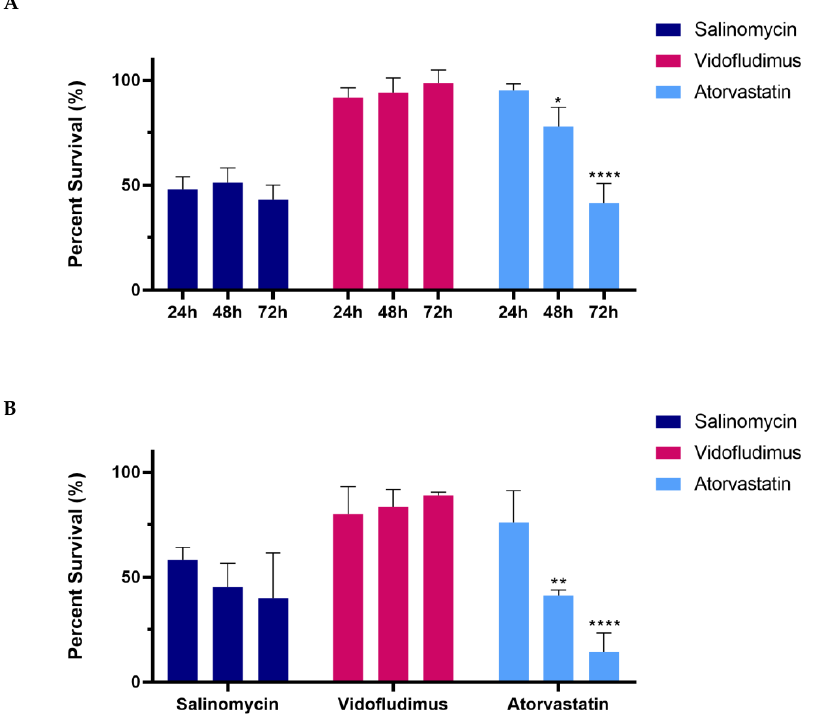
Figure 5. Candidate drug efficacy of THP-1 cells encapsulated in 6 mg/mL self-assembling peptide hydrogel (SAPH). ( A ) Bar graphs displaying the percentage survival of treated THP-1 cells 72 h after drug addition to ‘early-stage’ SAPH models. ( B ) Bar graphs displaying the percentage survival of treated THP-1 cells 72 h after drug addition in ‘established’ SAPH models. For all results, mean values ± standard deviation of biological replicates (N = 3, n = 3) are plotted throughout. Statistical significance (determined by two-way ANOVA in GraphPad Prism): * p < 0.05, ** p < 0.01, *** p < 0.001, **** p < 0.0001. All results are presented as percentages compared to vehicle (DMSO) control of 0.02% for calculated EC50 values in liquid culture (Figure 3).